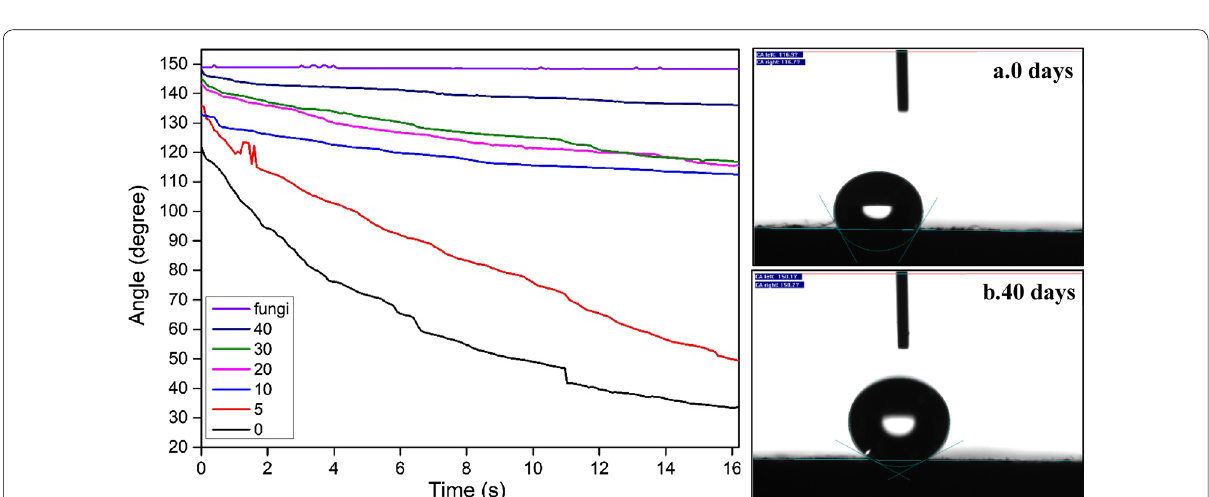
Fig. 5 Contact angle of fungi dyed rubberwood from 0 to 40 days. a Contact angle of undyed rubberwood; b contact angle of dyed rubberwood at 40 days